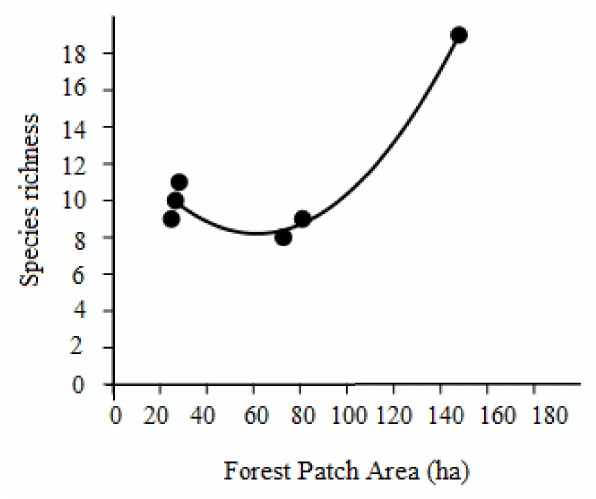
Figure 3. Order-2 polynomial relationship between forest patch area and species richness of medium and large mammals in the study area.